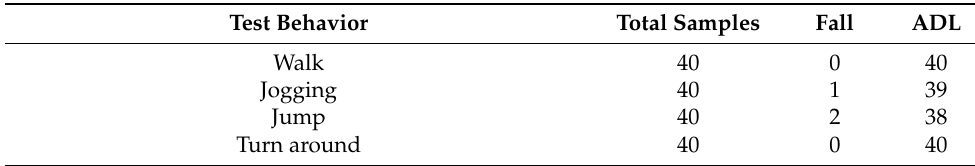
Table 6. Results of behavioral